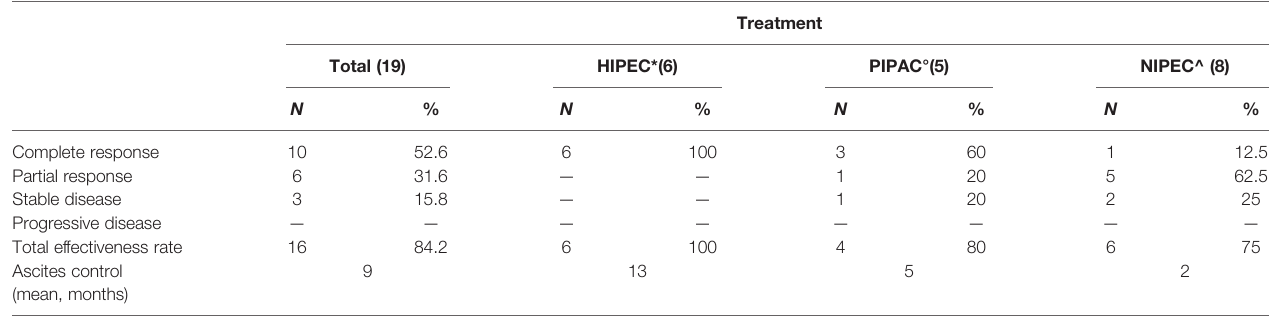
TABLE 3 | Strategies for controlling ascites in 19 patients in the non-curative group.